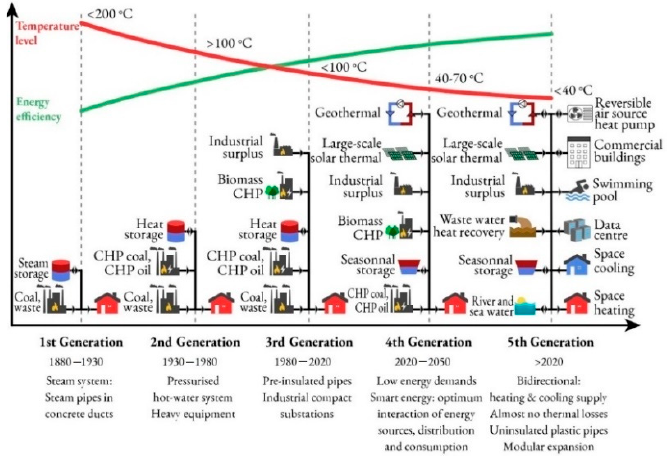
Figure 3. Characteristics evolution of the 5 generations of DHSs [42].